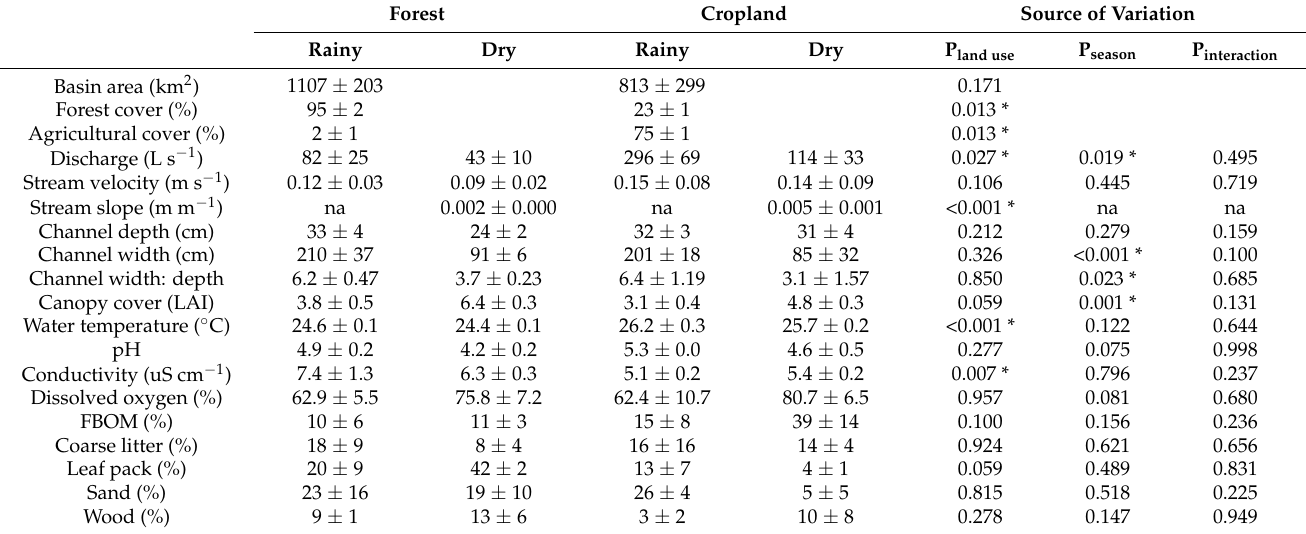
Table 1. Characteristics (mean ± SE) of forest and cropland streams in the rainy and dry seasons. Bold text and * indicate significant differences at p < 0.05. Stream slope is only reported in the dry season because it was only measured in the dry season and not anticipated to differ by season (na = not